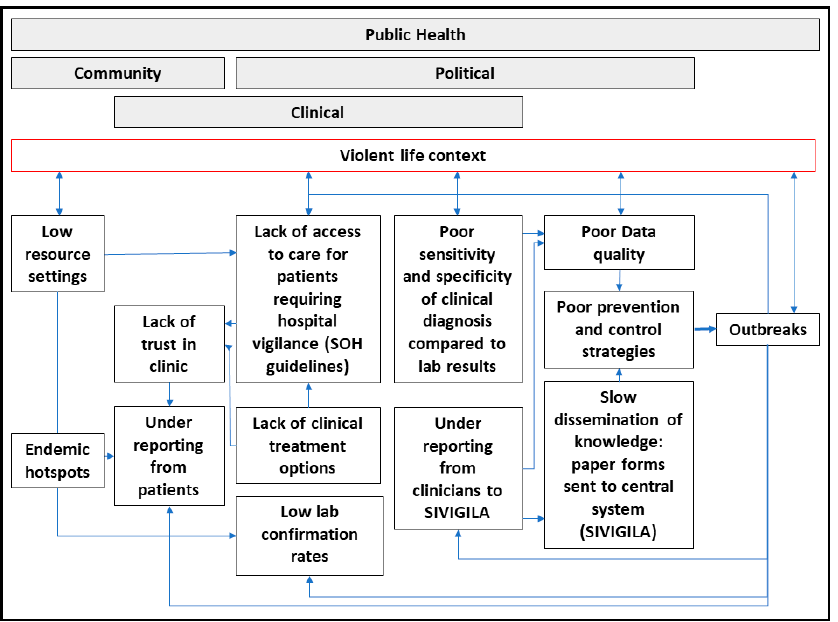
Figure 6. Gaps in current arboviral surveillance system and violence as barrier to preventative health service access.